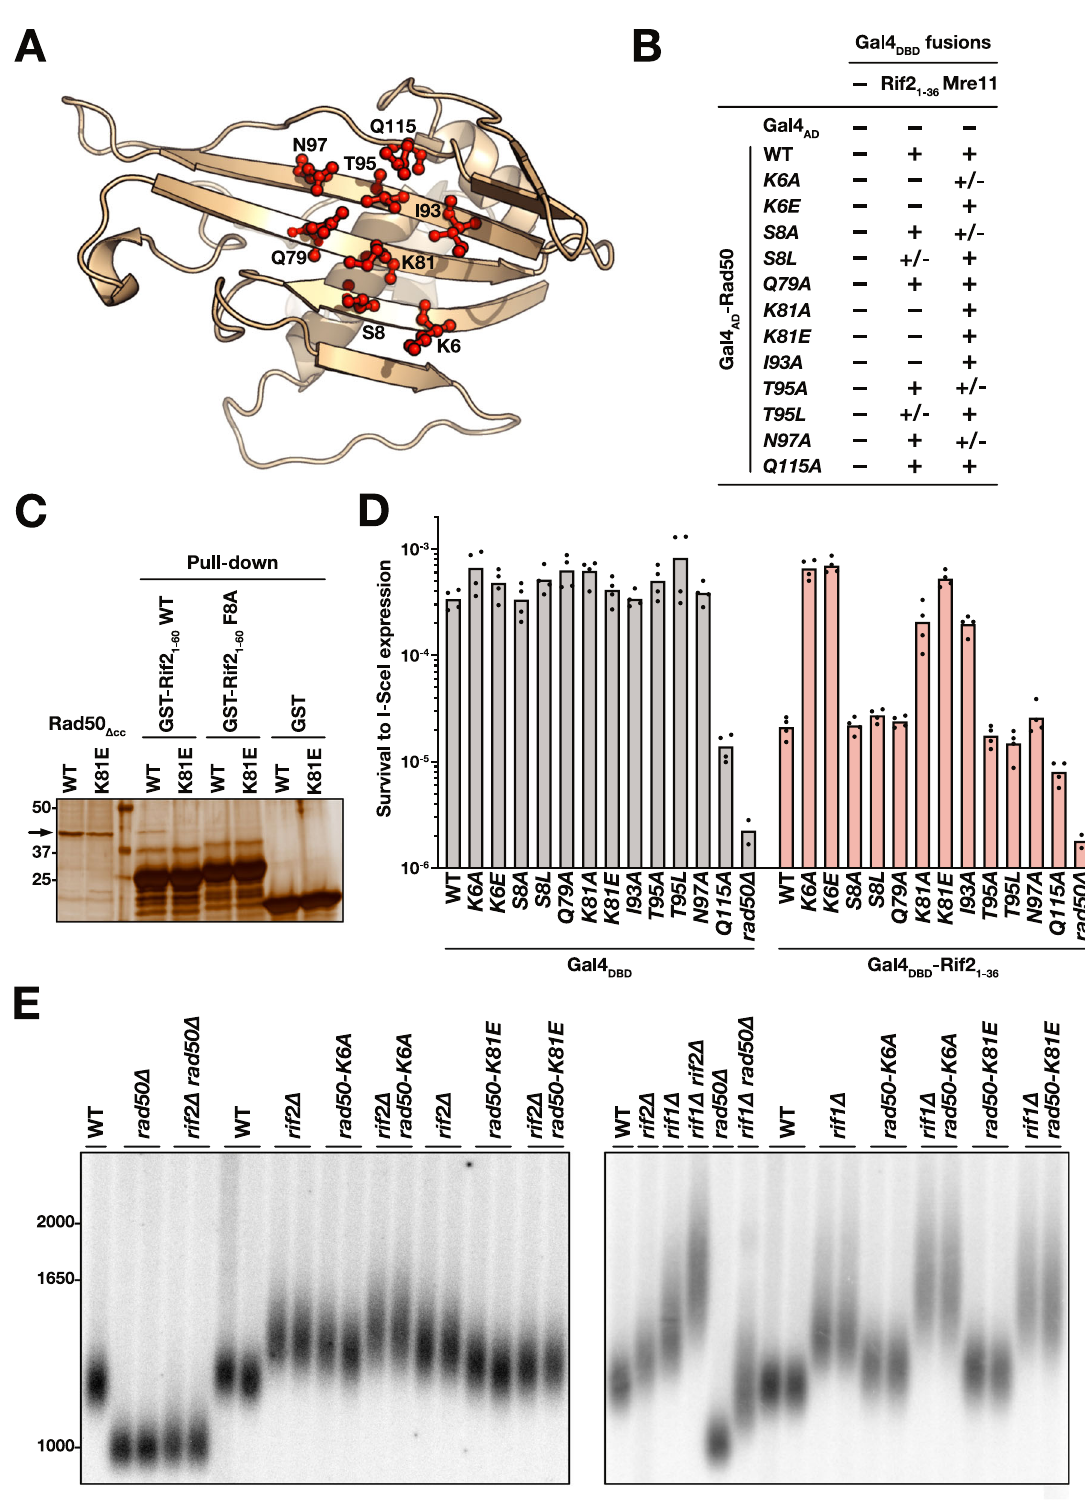
Fig. 6 Identi fi cation of Rad50 residues essential for BAT function and interaction. A Position of the eight residues (red) selected with CABSdock as potentially interacting with Rif2 BAT. B 2-Hybrids interactions between mutant full-length Rad50 and Rif2 N-terminal region or full-length Mre11. C GST pull-down interaction between Rif2 N-terminal region and Rad50 ATPase Head. Experiment reproduced three times. D NHEJ inhibition by Rif2 BAT motif at I-SceI-induced broken ends in rad50 mutants (single I-SceI site assay (Supplementary Fig. 2B)). Means from independent cell cultures. E Impact on telomere length of mutants rad50-K6A and rad50-K81E in WT cells and in cells lacking Rif1 or Rif2 (Southern blot, Y ′ probe, XhoI digest). Experiment reproduced three